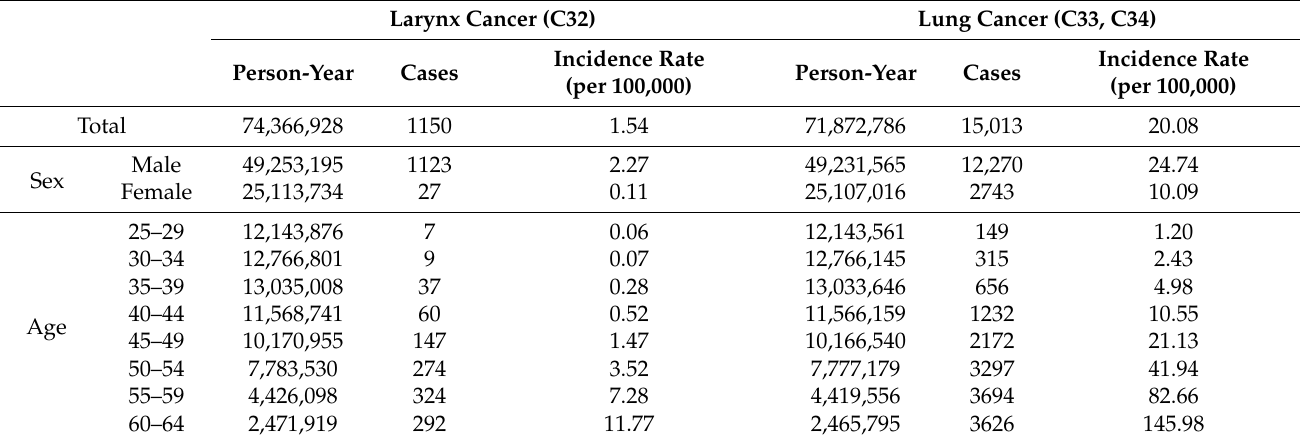
Table 2. Follow-up period and number of incidence cancer cases according to sex and age group.